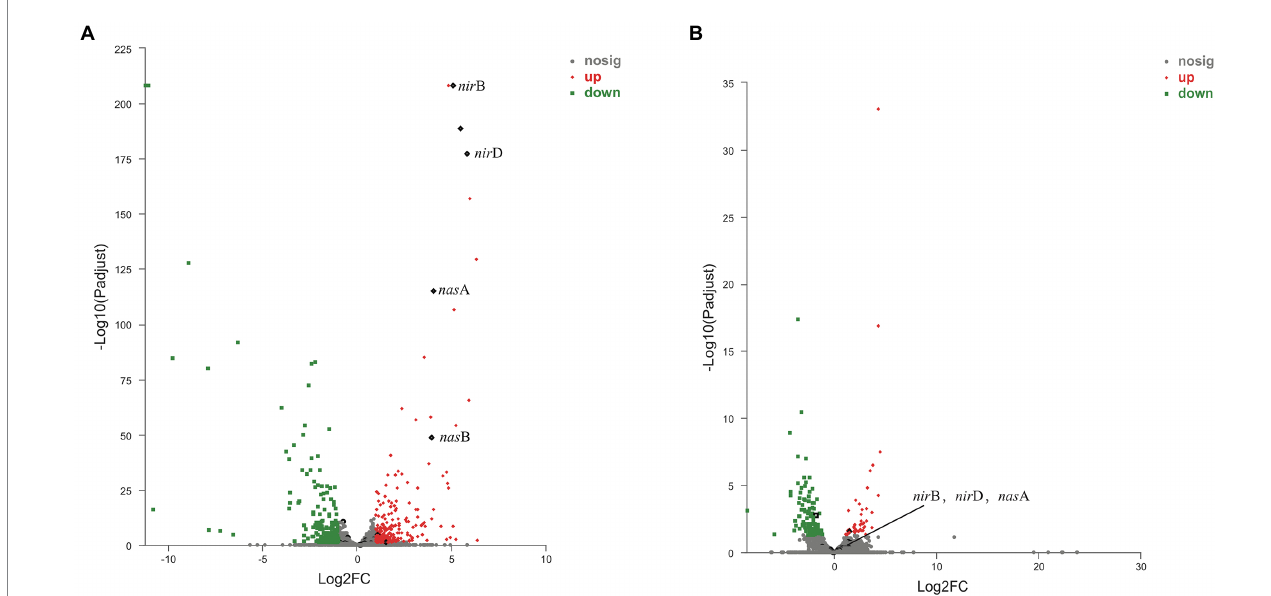
FIGURE 6 Volcano plot of the difference in gene expression between strain 24S4–2 in nitrate medium and ammonium medium (control). (A) Volcano plot of the difference in gene expression between strain 24S4–2 in nitrate medium and ammonium medium (control), (B) Volcano plot of differential gene expression of strain 24S4–2 in nitrogen-free medium and water (control) after 114 h incubation in nitrate medium. Red points indicate up-regulated expression genes; green points indicate down-regulated expression genes; black points indicate DNRA pathway-related genes.